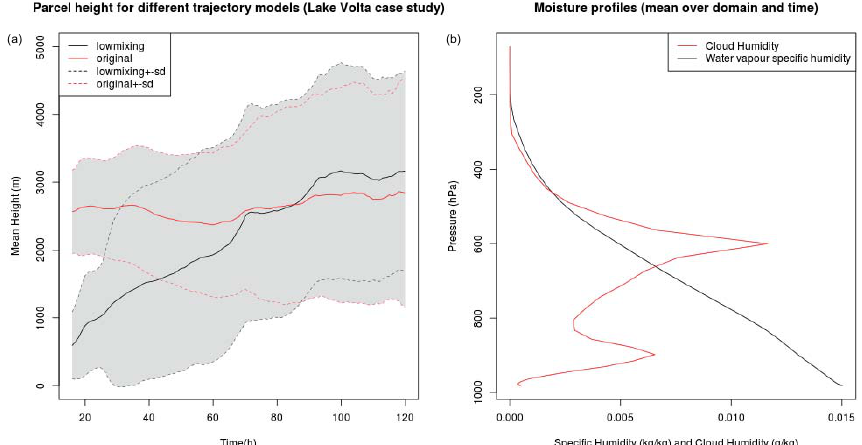
Fig. 9. (a) mean height of parcels in 3D-T for two mixing assumptions for evaporation entering the atmosphere. The red line shows the original assumption in which evaporated moisture is released randomly along the vertical moisture profile (Fig. 5 and movie 3, Supplement). The black line shows the assumption where moisture is released at 50m above the land surface. Dotted lines and grey shading shows the range of one standard deviation from the mean height. Both lines are based on a sample size of 1000 parcels. (b) vertical moisture profile (averaged over the domain for August 1998). The red line shows the cloud water content and the black line the specific